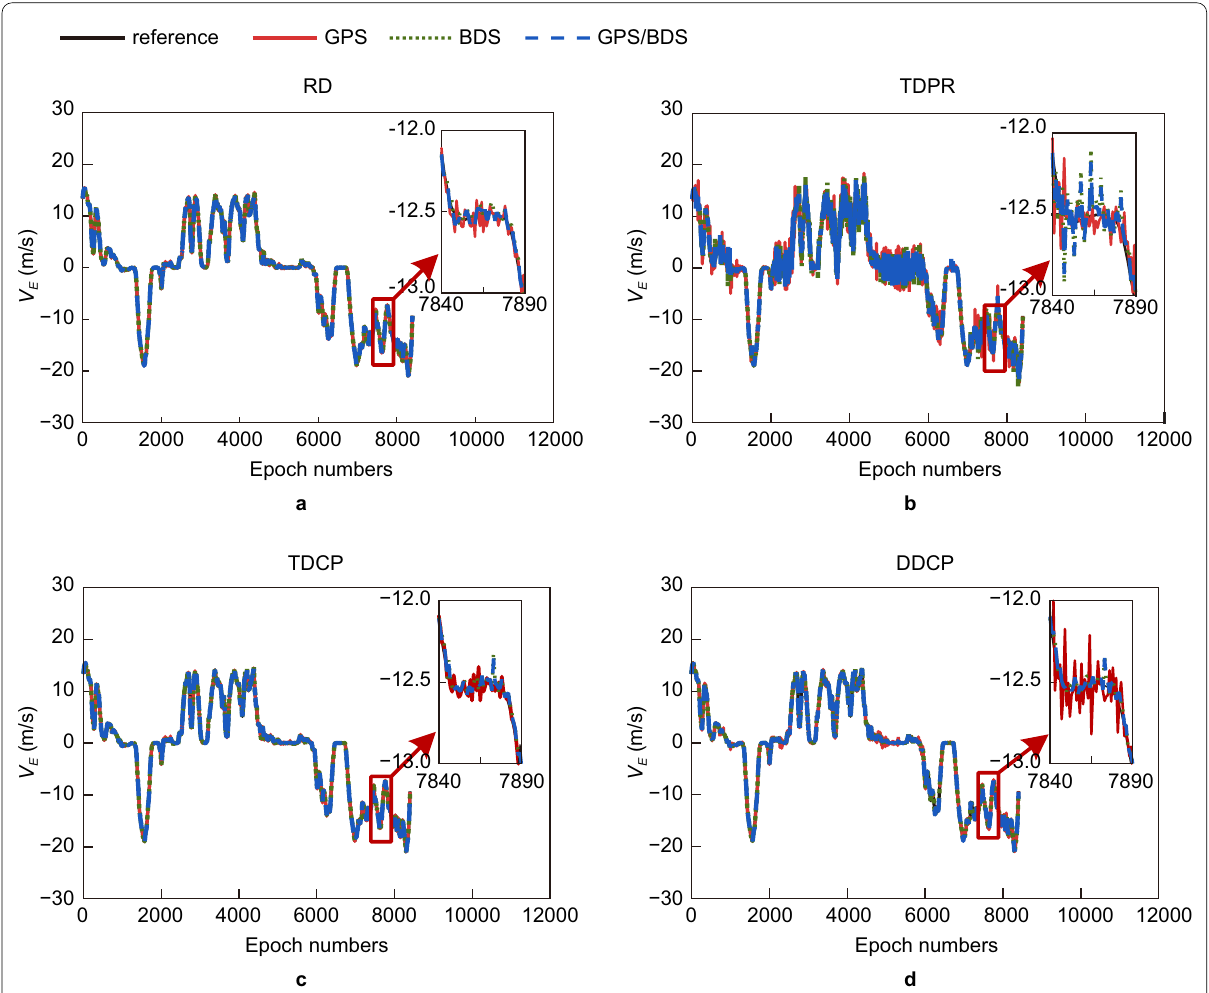
Fig. 9 Velocity determination results and zoomed-in windows in east component for the RD- ( a ), TDPR- ( b ), TDCP- ( c ) andDDCP- ( d ) based methods in test